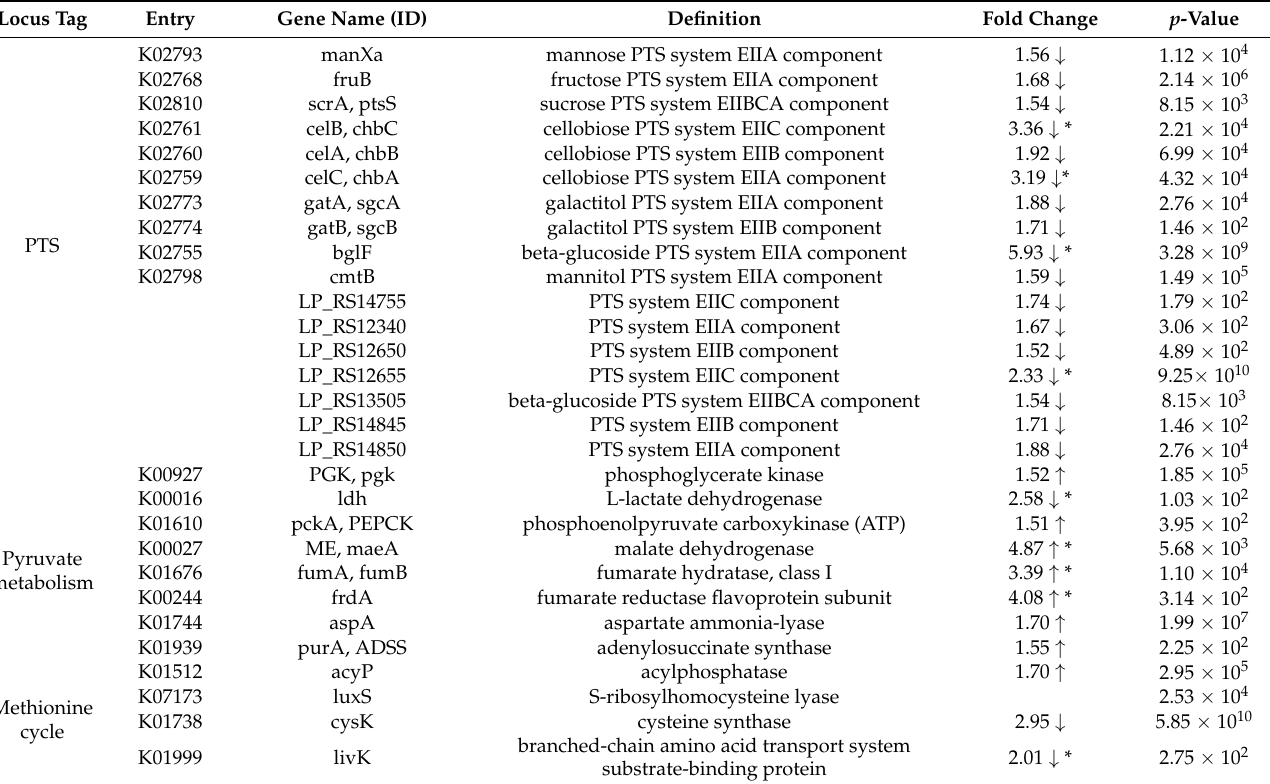
Figure 4. PCA analysis ( a ), volcano plot ( b ), and KEGG pathway of DEGs at level 2, ( c ) ( ∆ luxS /SS- 128 vs. SS-128). Table 2. DEGs involved in PTS, pyruvate metabolism and quorum